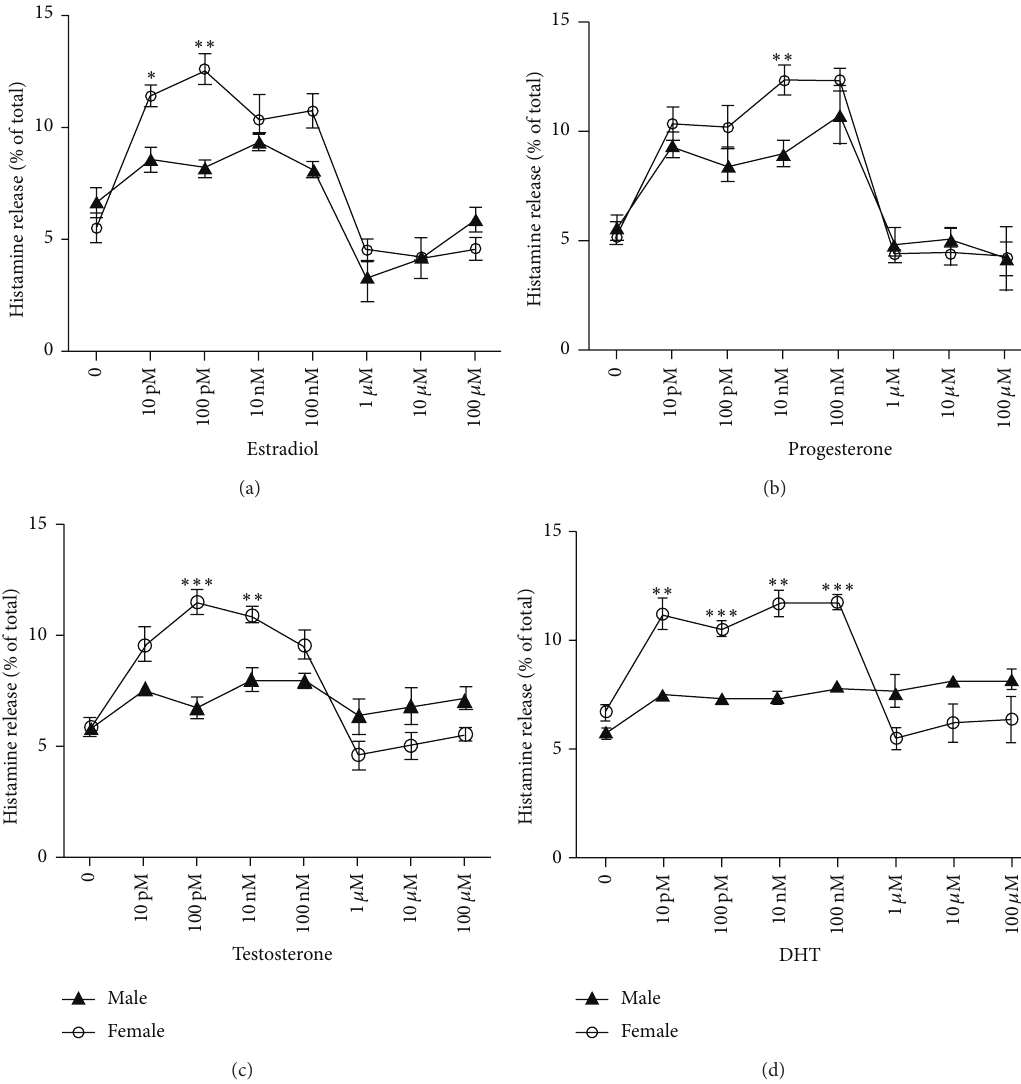
Figure 1: Gender and sex steroid concentration effect on histamine release in mast cells. Rat PMCs were treated with physiological (10pM to 10nM) and pharmacological concentrations (100nM to 100 𝜇 M) of estradiol, progesterone, testosterone, and DHT for 30min at 37 ∘ C. Values are means ± SEM of three independent experiments in triplicate. ∗ 𝑃 < 0.05 , ∗∗ 𝑃 < 0.01 , and ∗∗∗ 𝑃 < 0.001 female versus male at each hormone concentration. Comparisons between genders were performed by one-way analysis of variance (ANOVA), followed by Bonferroni’s multiple comparison test (GraphPad Prism). Basal histamine release was determined in nontreated PMC (no hormone treatment). Hormone concentration and gender had significant effect and the interaction is statistically significant ( 𝑃 < 0.001